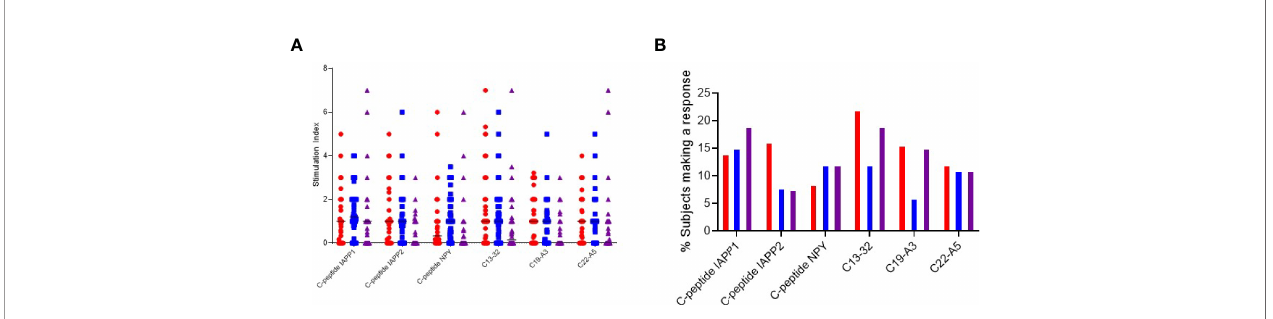
FIGURE 3 | Cytokine T cell responses were measured by ELISPOT, and data are expressed as SI [stimulation index (mean spot number of test peptide/mean spot number of diluent)]. (A) Magnitude of IFN- g (red) IL-10 (blue) and IL-17 (purple) responses depicted as stimulation indices for individual peptides of neoepitopes (three on the left) and native (three on the right) in preclinical and subjects with type 1 diabetes. (B) Frequency of IFN- g (red) IL-10 (blue) and IL-17 (purple) responses to individual peptides of neoepitopes (three on the left) and native (three on the right) in preclinical and subjects with type